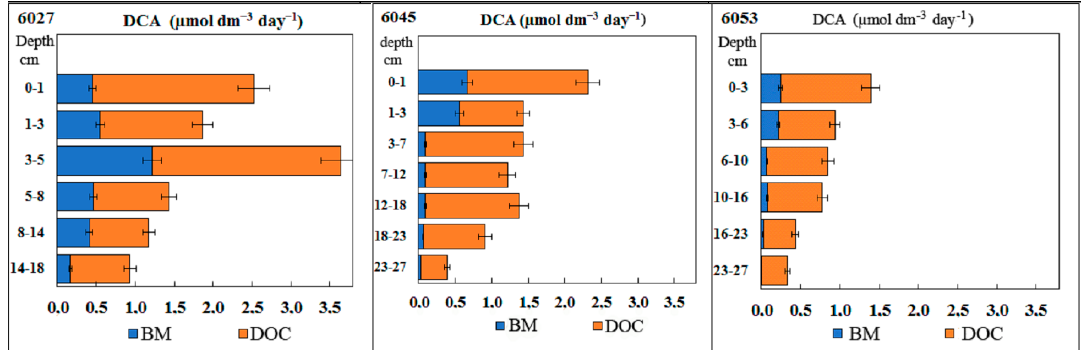
Figure 8. Rates of dark CO 2 assimilation (DCA, µ mol dm − 3 day − 1 ) in the Laptev Sea shelf sediments. CO 2 carbon assimilation into organic matter of microbial biomass (BM) and dissolved organic carbon (DOC).